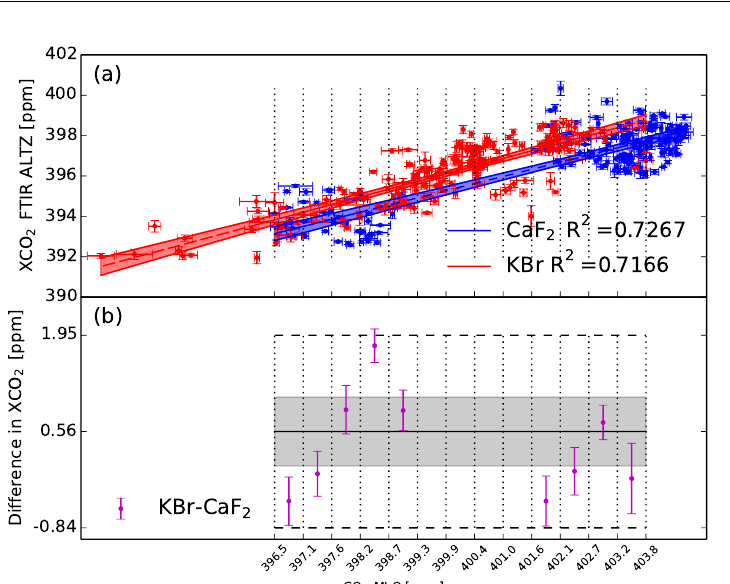
Figure 7. (a) shows the coincidences between the hourly means of the X CO from the KBr (red) and CaF 2 (blue) ensembles and the CO 2 2 from the Mauna Loa Observatory (MLO) data set with a linear regression of the two sets, with the shaded area representing a 95% confidence interval. (b) shows the difference of means of KBr and CaF 2 (purple points) for each bin (vertical lines) in a Bland–Altman plot, with the black dashed lines showing the standard deviation of all points. The black solid line represents the bias and the shaded area the standard error of the bias, both reported in Table